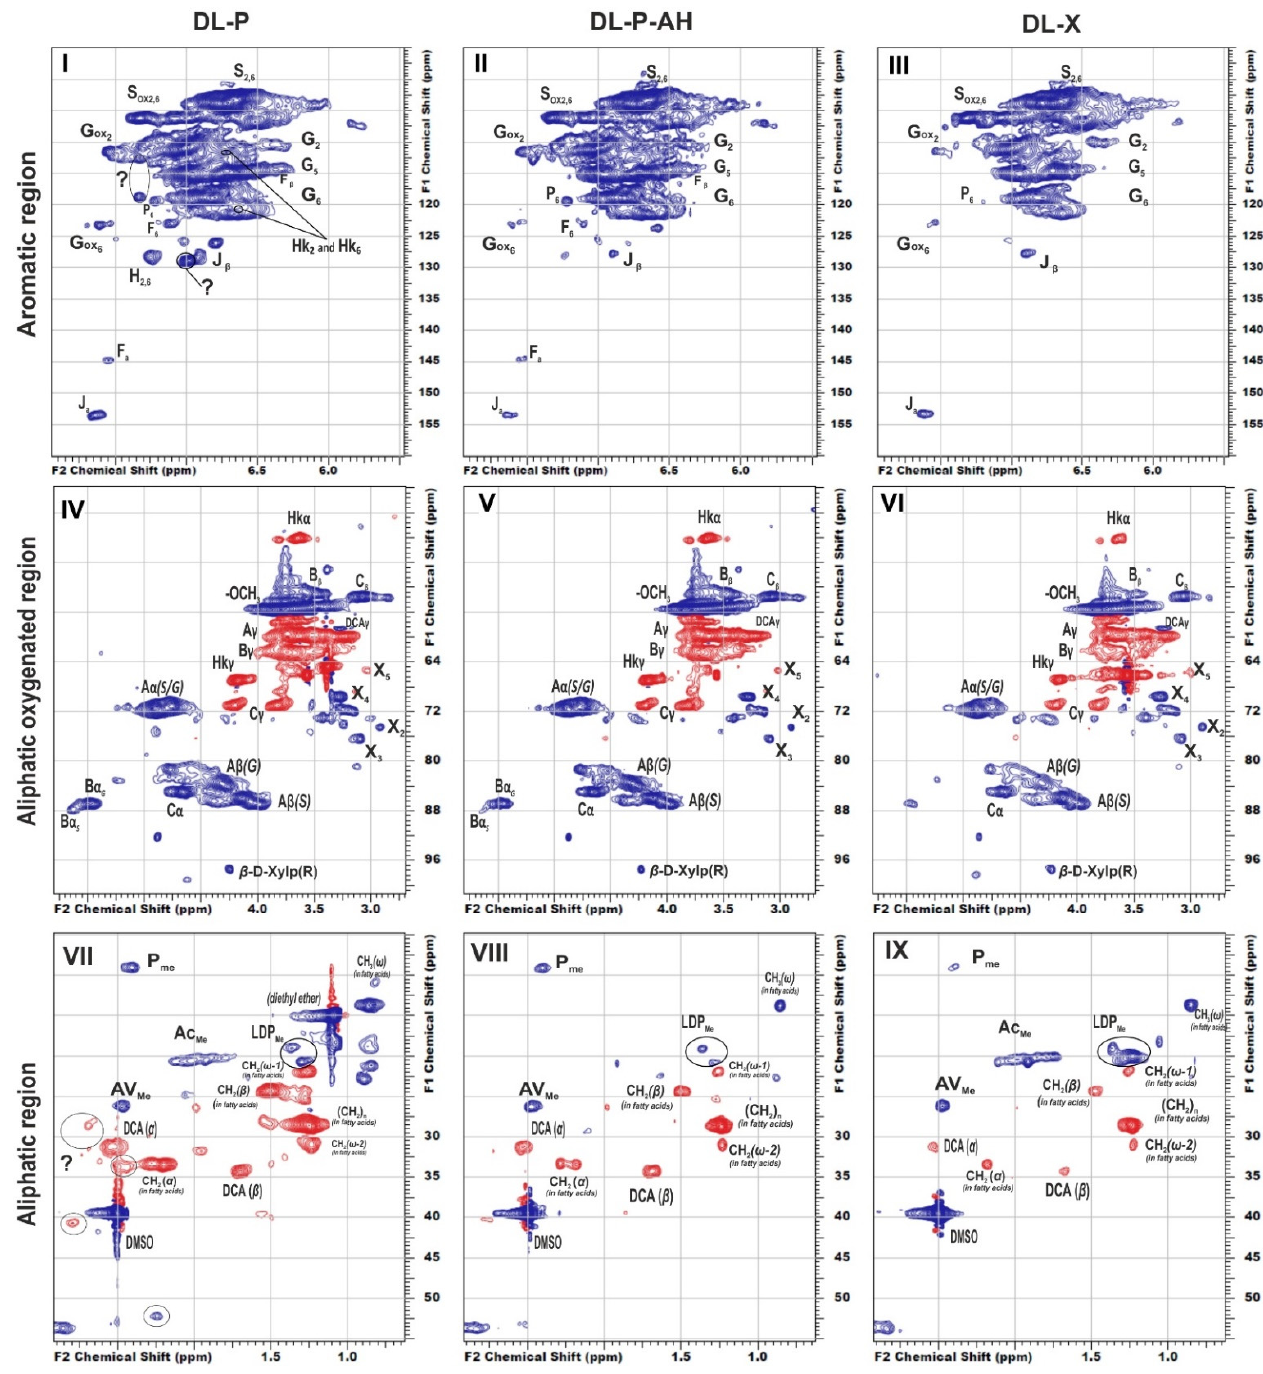
Figure 1. Key regions of HSQC spectra of birch lignin: DL-P ( I , IV , VII ); DL-P-AH ( II , V , VIII ); DL-X ( III , VI , IX ). The signal assignments are listed in Table S1. The main lignin structures identified are depicted in Figure